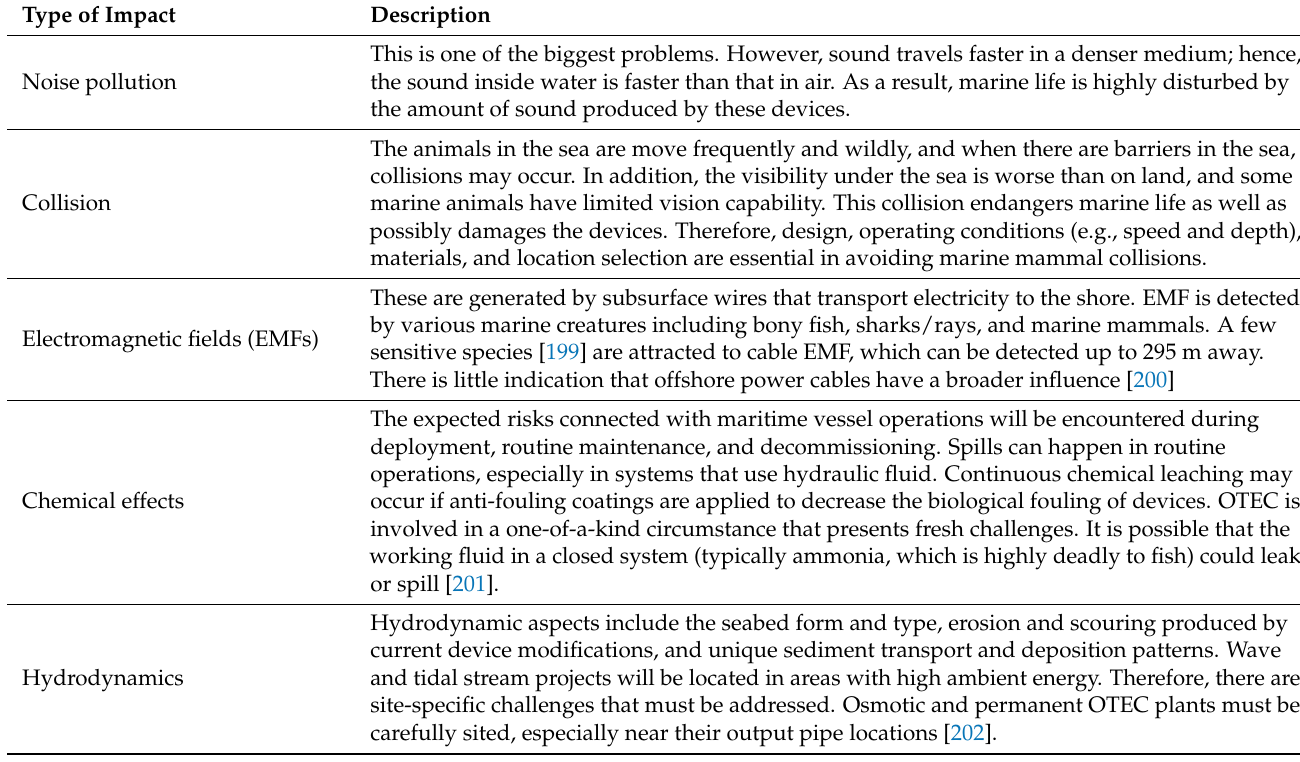
Table 9. The possible impacts of ocean tidal and wave energy harvesting on the environment and others. Type of Impact